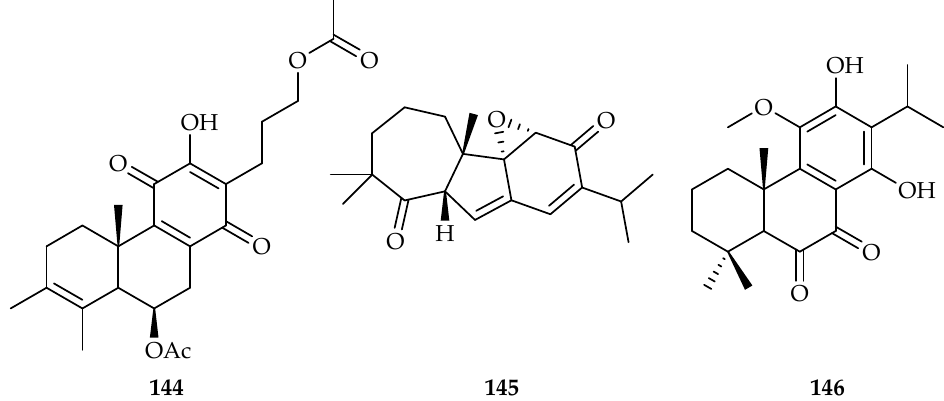
Figure 59. Structures of 6-acetylfredericone B 144 [88], salviyunnanone A 145 [89], and complanatin D 146 [90].